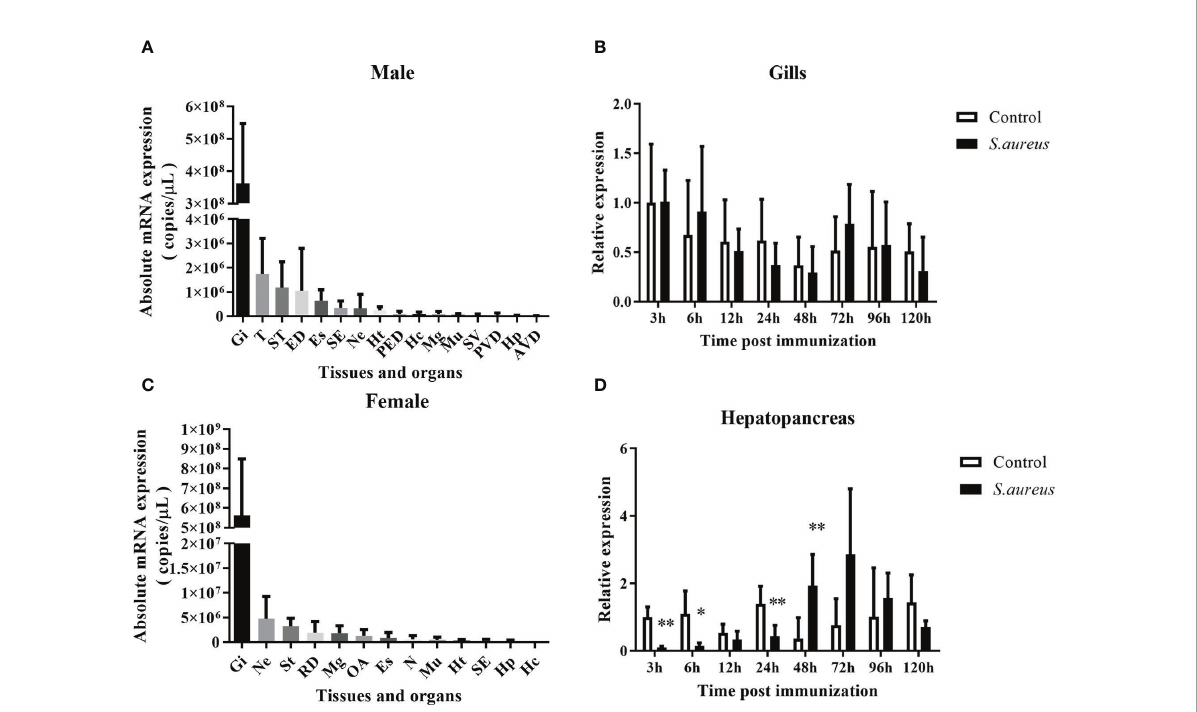
FIGURE 2 Expression pro fi les of Spgillcin in S. paramamosain . Tissue distribution of Spgillcin was detected in adult male (A) and female (B) crabs ( n = 3). Relative expression levels of Spgillcin in the gills (C) and hepatopancreas (D) of male crabs after S. aureus challenge. Data are presented as mean ± standard deviation (SD), * P < 0.05 and ** P < 0.01. Gi, gills; T, testis; ST, stomach; ED, ejaculatory duct; Es, eye stalk; SE, subcuticular epidermis; Ne, thoracic ganglion; Ht, heart; PED, posterior ejaculatory; Mg, midgut; Mu, muscle; SV, seminal vesicle; PVD, posterior vas deferens; RD, reproductive duct; Hp, hepatopancreas; AVD, anterior vas deferens; OA, ovary; Hc, hemocytes; N,